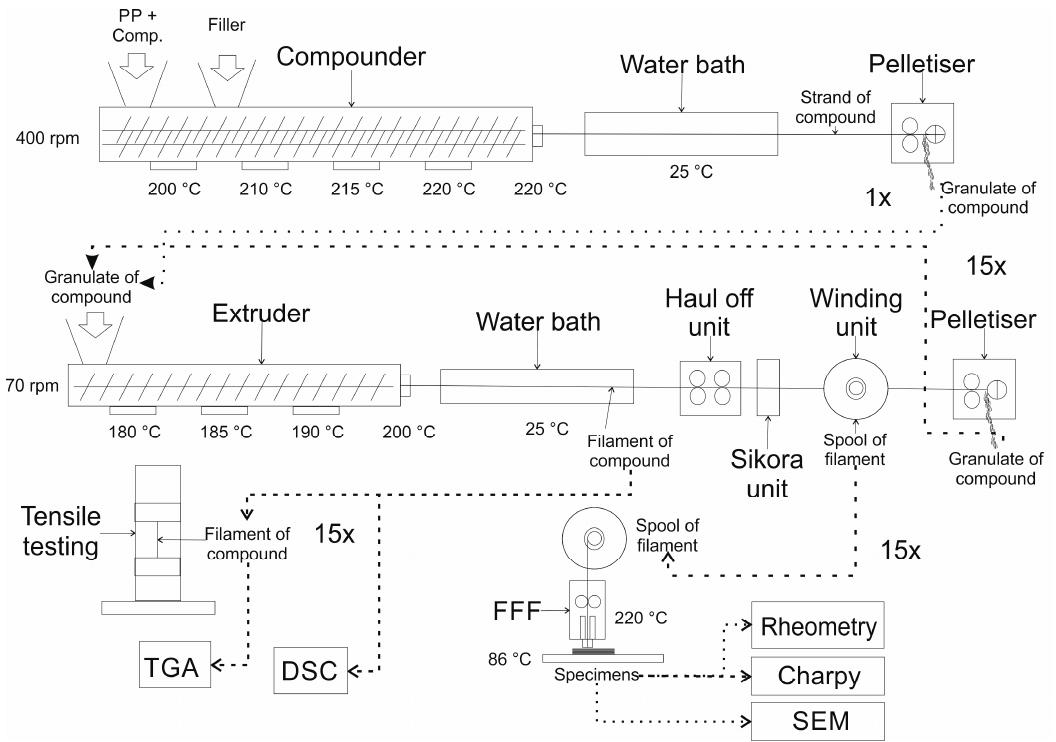
Figure 1. Schematic representation of the complete experimental procedure.